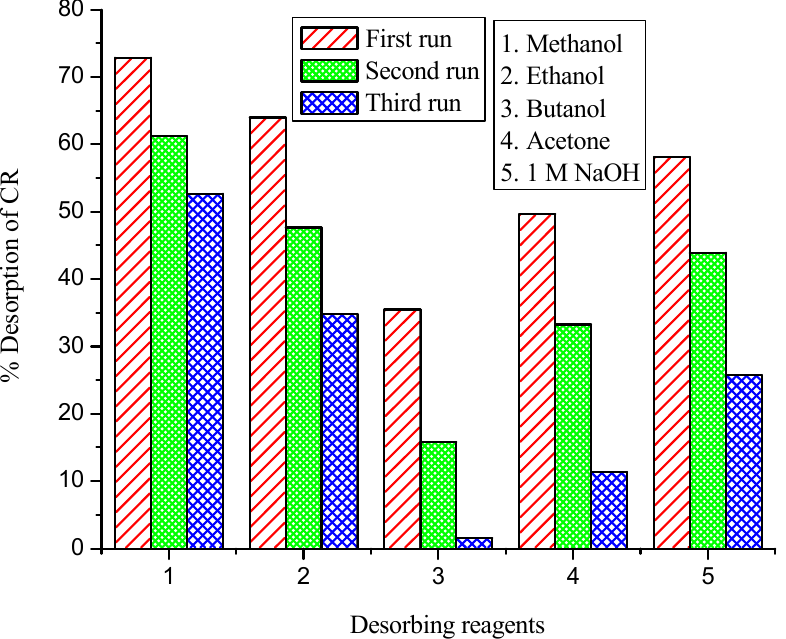
Figure 3. Desorption efficiency of CR dye from sodium silicate gel-immobilized NNLP adsorbent in various runs. (Volume of desorbing reagent: 100 mL; shaking speed: 150 rpm; temperature: 301 K; contact time: 24 h)